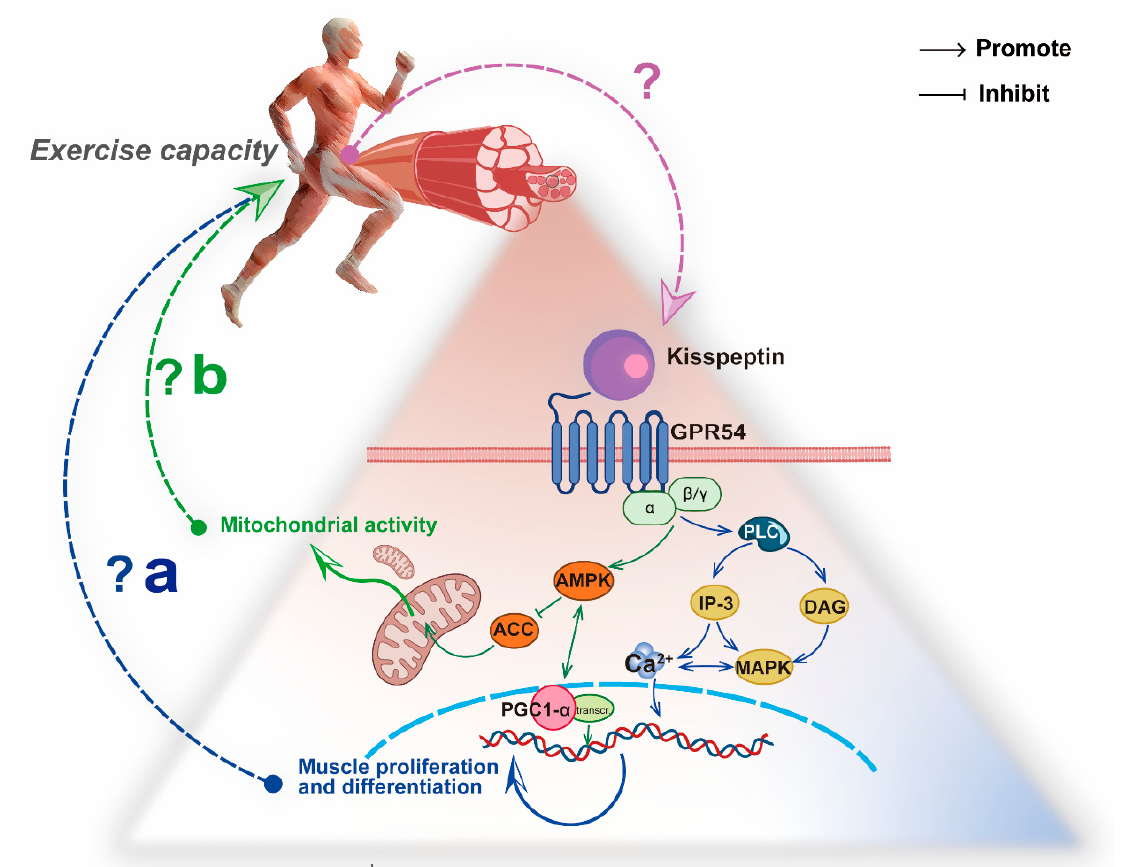
Figure 4. The hypothesis between the Kiss1/GPR54 system in skeletal muscle and exercise capacity. ( a ) Kisspeptin regulates Ca 2+ concentration in skeletal muscle to promote proliferation and differentiation via the PLC-MAPK/IP-3 pathway. ( b ) Kisspeptin inhibits ACC in skeletal muscle to promote mitochondrial activity by APMK and PGC1 α .